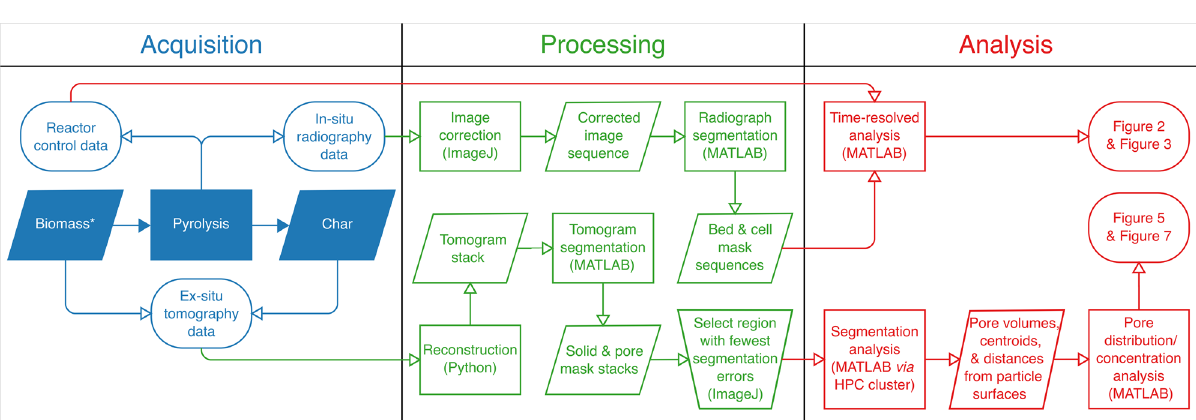
Fig. 9. Subsequent steps, including segmentation and analysis, relied entirely on custom MATLAB code, which has been made publicly available in full under an open-source license 58 . Statistics.